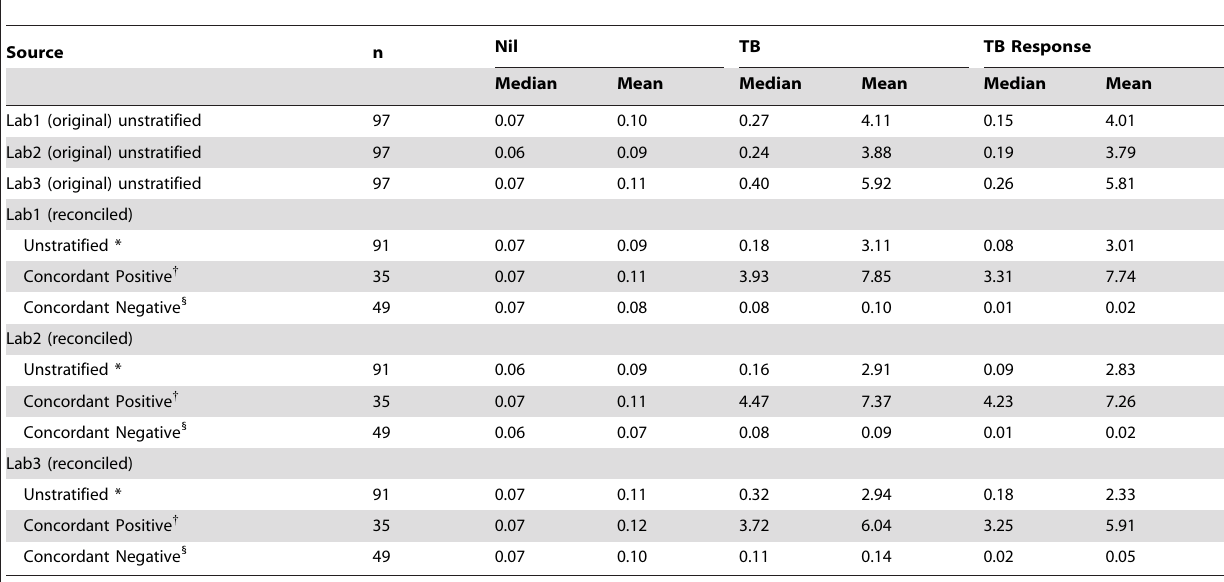
Table 4. Median and mean IFN- c measurements for QuantiFERON-TB Gold In-Tube tests performed on the same subjects in three